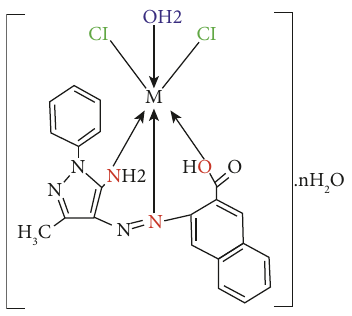
Figure 1: Te proposed structure of the metal complexes (M � Cu(II), Co(II), and